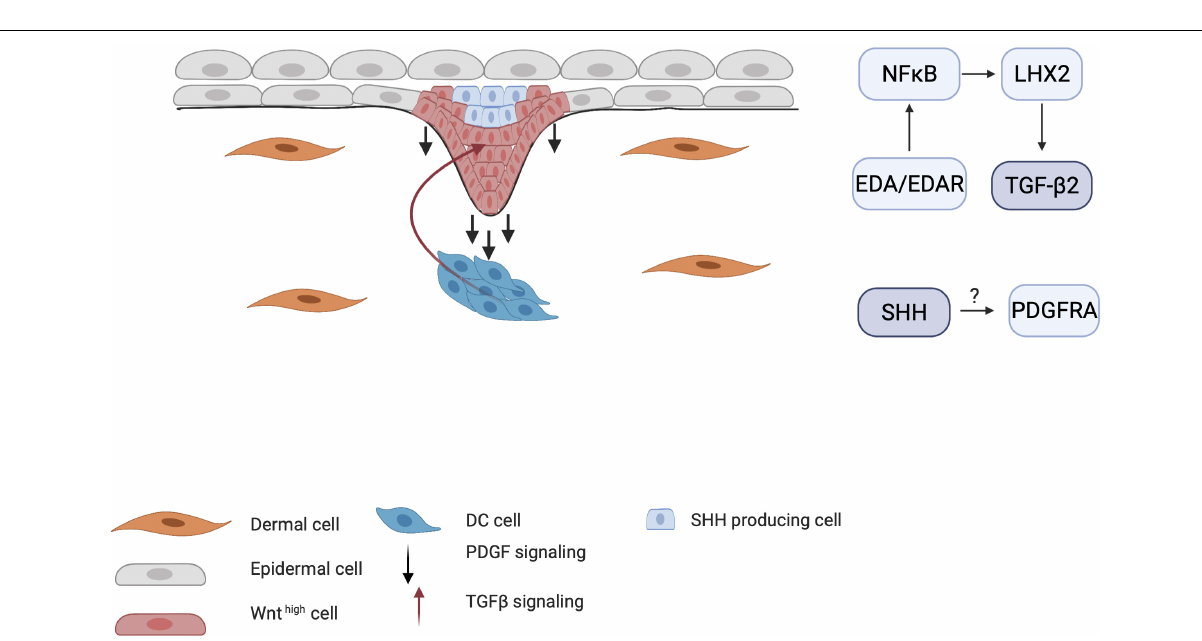
FIGURE 6 | Influence of TGF- β and PDGF on placode formation. Although the mechanisms by which PDGF receptors are induced are unknown, PDGFRA-positive cells become more restricted around the DC as maturation continues. TGF- β 2 is also crucial for HF downgrowth through the NF- κ B/LHX2 pathway through establishment of a balance between stimulating and inhibitory WNT concentration